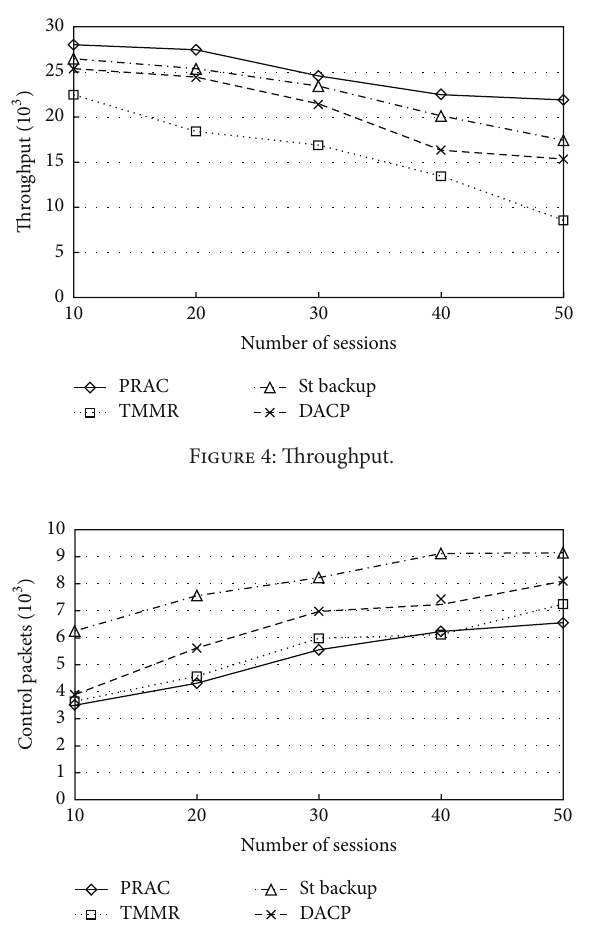
Figure 5: Control packets overheads.